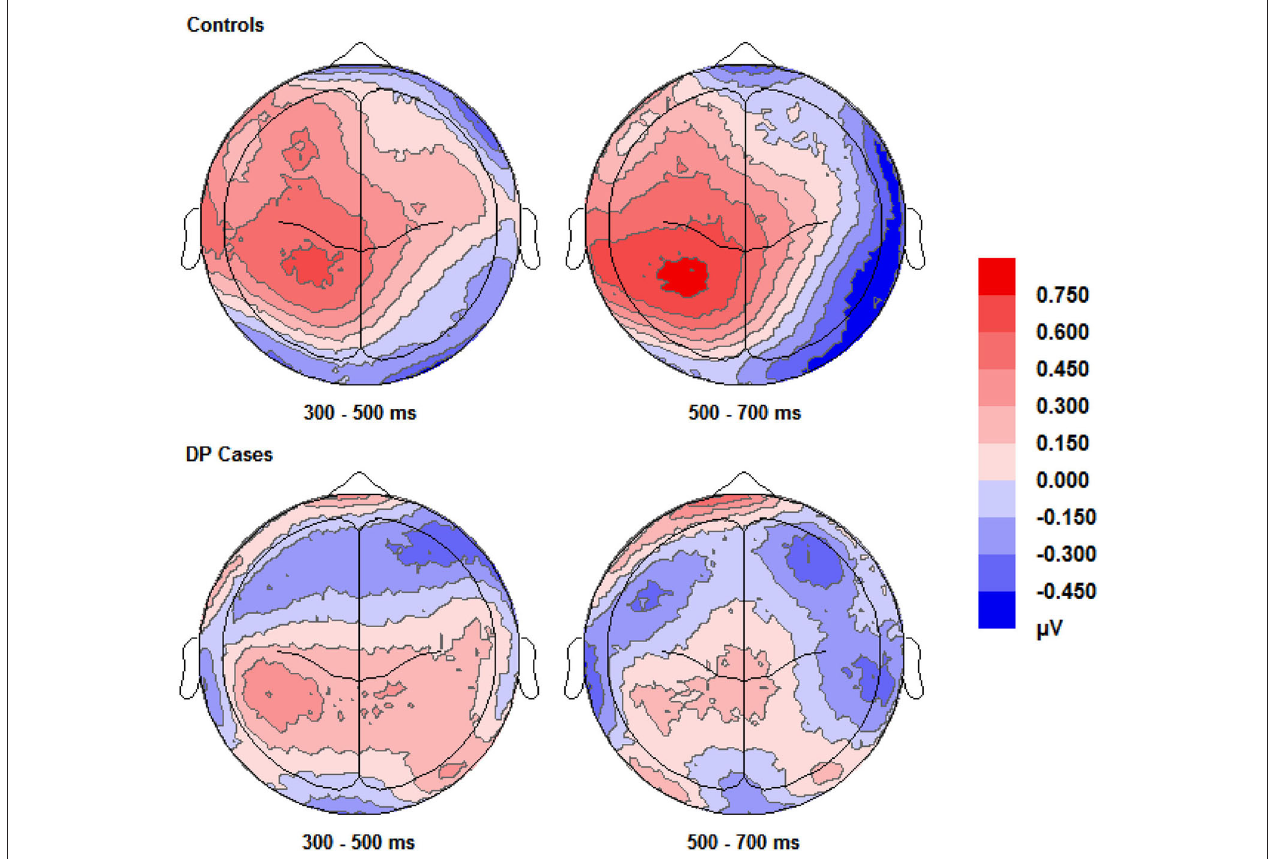
FIGURE 3 | Scalp maps (shown as if viewing from above the head) for the voltage corresponding to correct “know” responses minus that for correct rejections . Data for both groups and time intervals are shown across the four